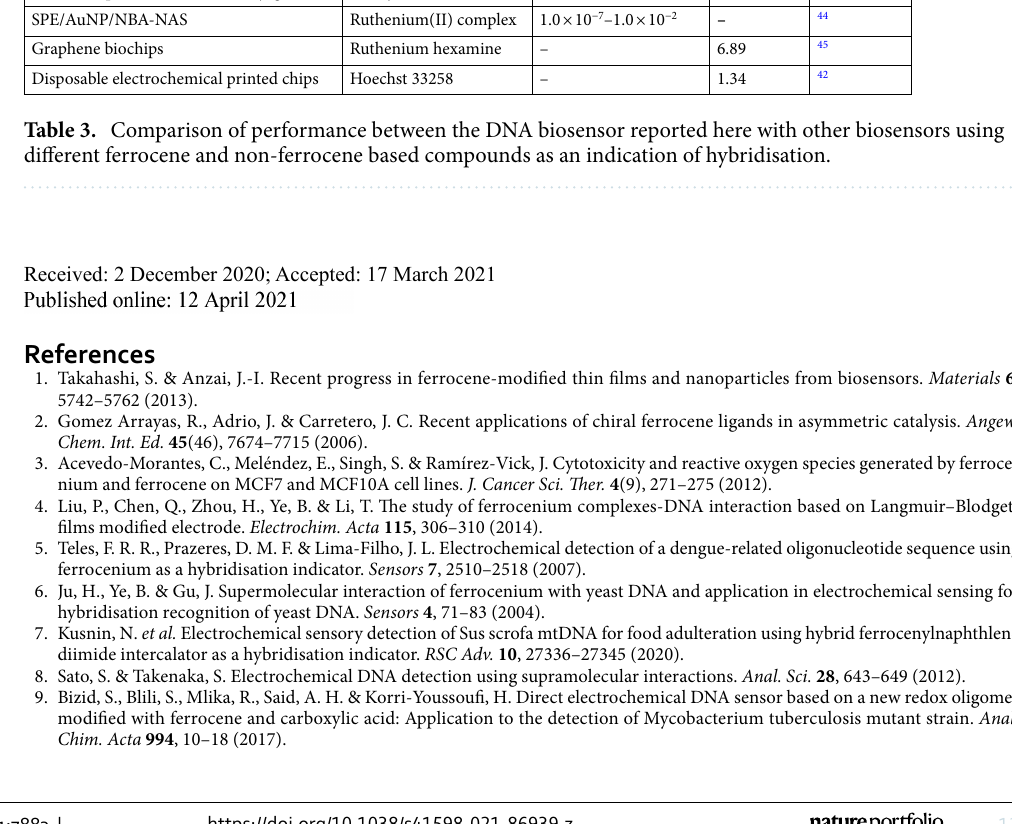
DNA electrode materials DNA